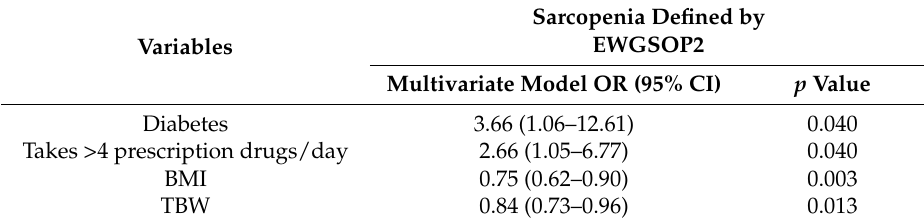
Table 3. Multivariate logistic regression for the associated risk factors for